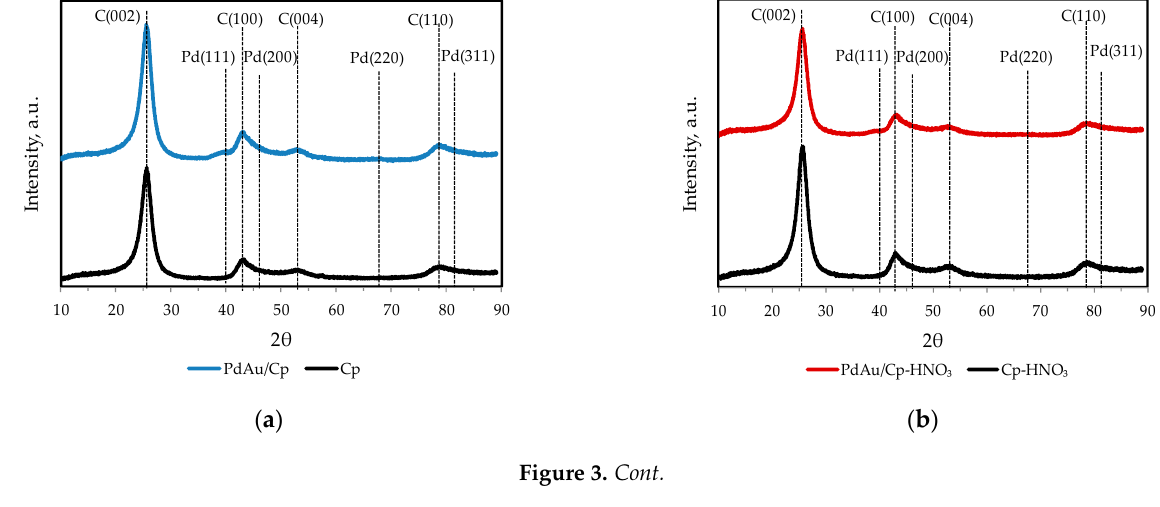
Table 4. Analytical content of Pd and Au in Sibunit-supported catalysts with different support treatment.